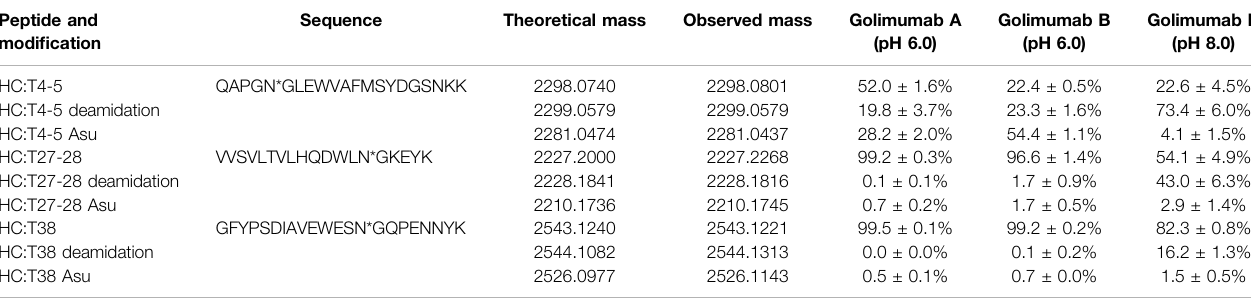
“ * ” indicates the modi fi cation